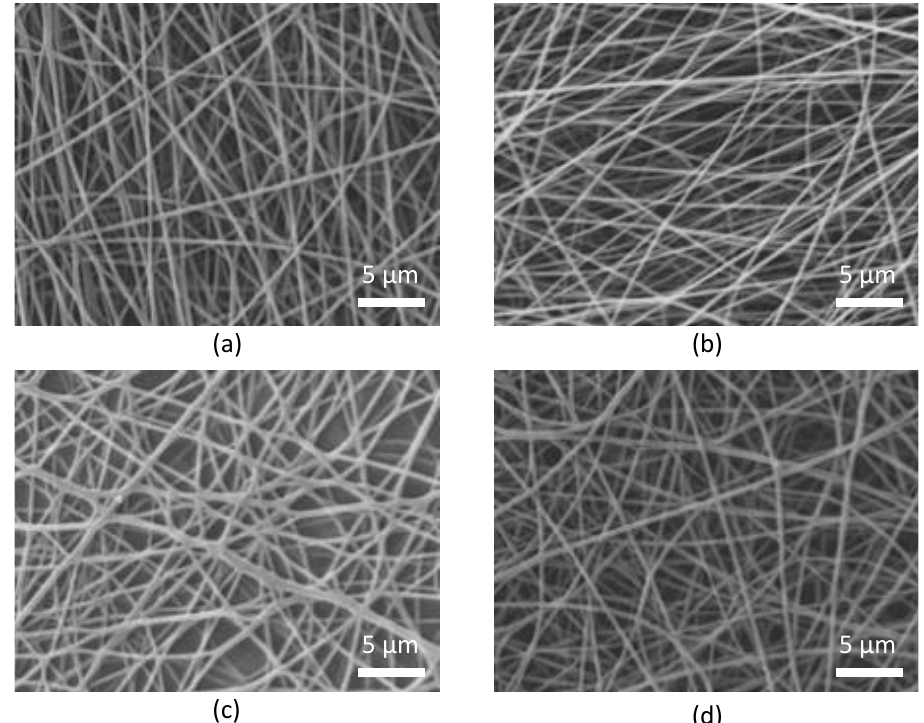
Figure 3. Scanning electron microscopic (SEM) images of lipase Burkholderia cepacia (PS Lip) entrapped in poly(vinyl alcohol) (PVA 18-88) nanofibers with ( a ) β-cyclodextrin (B-CD) and ( b ) with 2-hydroxypropyl-β-cyclodextrin (HPB-CD); and lipase from Aspergillus oryzae (AO Lip) entrapped in PVA nanofibers with ( c ) HPB-CD and with ( d ) sulfobutylated-β-cyclodextrin (SBB-CD) at magnification 3500×. All the fibers presented on the SEM images contain 10% ( w / w , relative to the sum mass of the fibers) lipase and CD in specific lipase:CD mass ratios (PS Lip:CD = 1:1, AO Lip:CD = 1:3 ( w/w )).